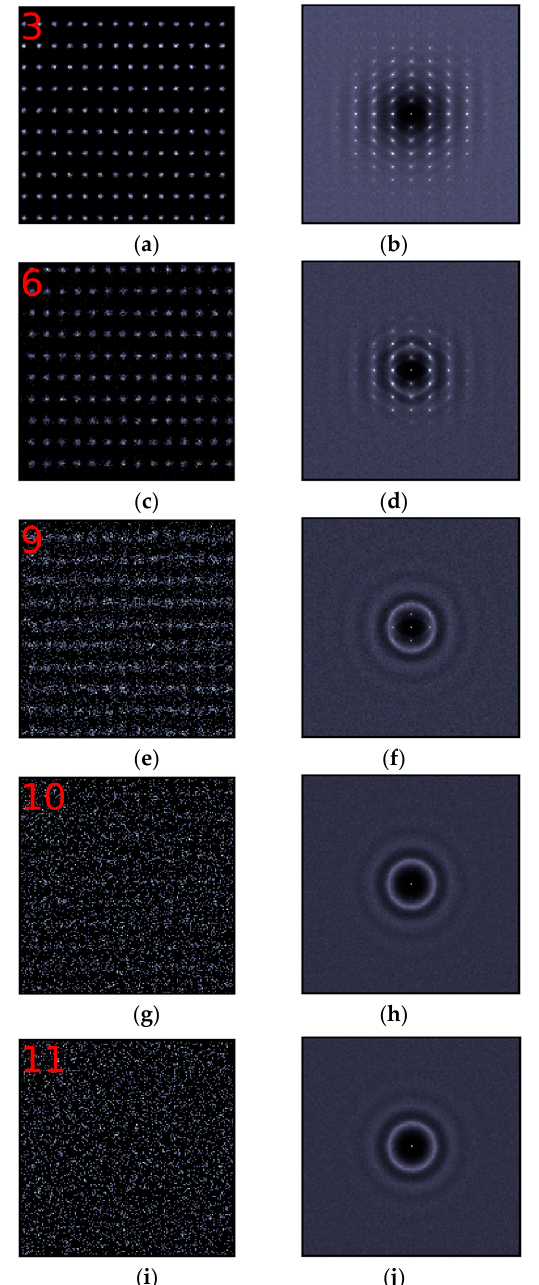
Figure 3. In ‐ plane ordering in the (110) interfacial layers. Left panel ( a , c , e , g , i ): 2 ‐ D density maps. The red numbers correspond to those defined in Figure 1. Right panel ( b , d , f , h , j ): 2 ‐ D structure factors for the corresponding layers.